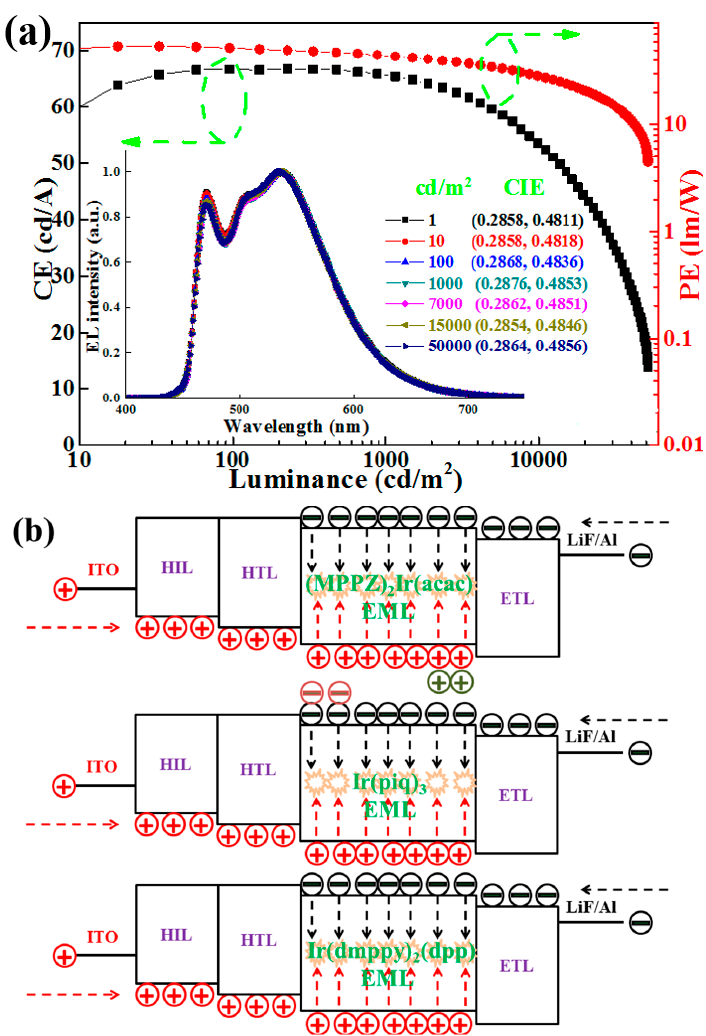
Figure 8. ( a ) Forward-viewing CE and PE. Inset: EL spectra. ( b ) Diagrams of EL processes in WOLEDs with the guests of (MPPZ) 2 Ir(acac), Ir(piq) 3 and Ir(dmppy) 2 (dpp). Reproduced from Reference [132] with permission from the Royal Society of Chemistry.